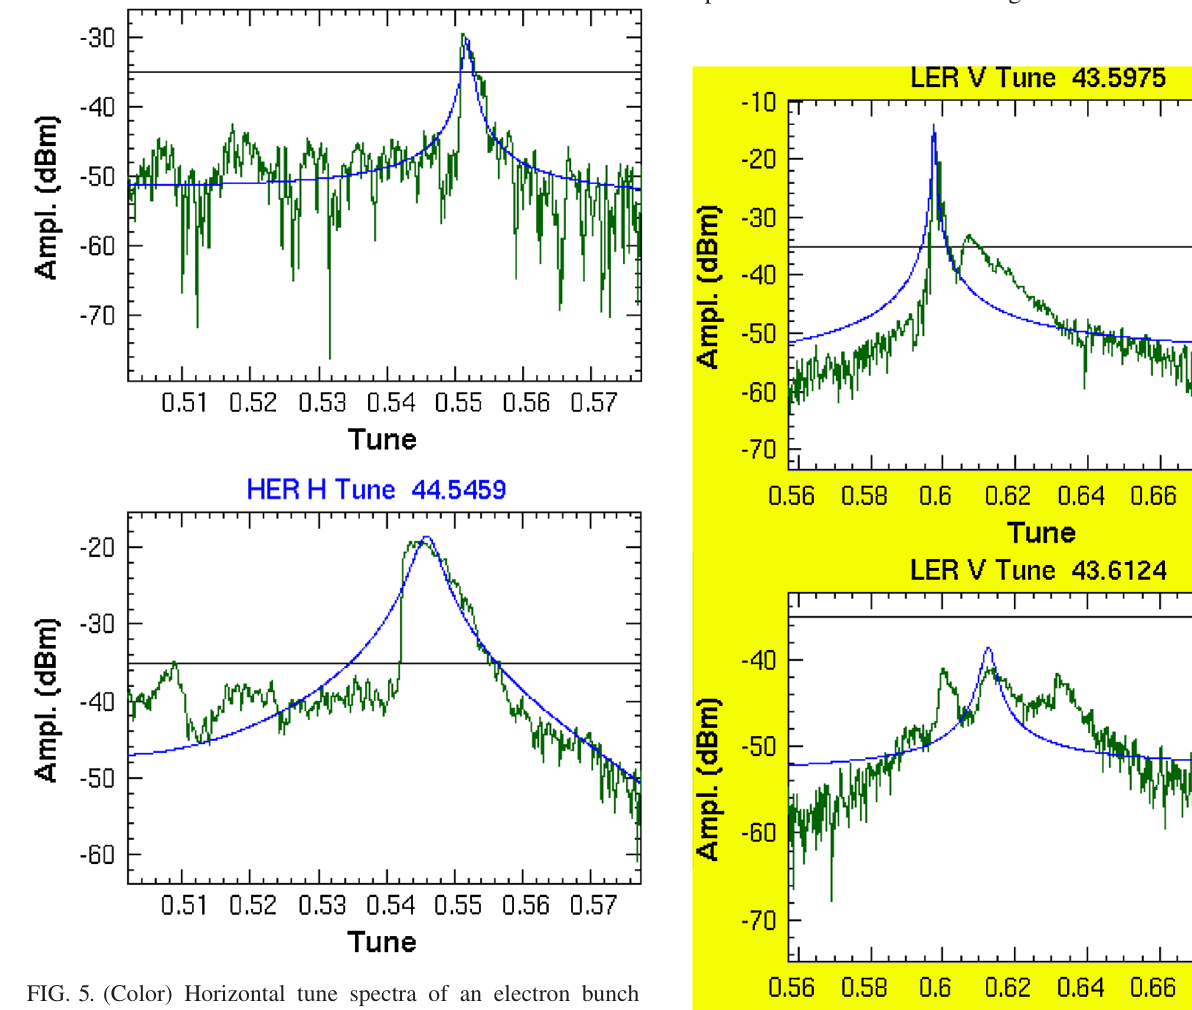
FIG. 5. (Color) Horizontal tune spectra of an electron bunch denoted by the green curve. The blue line is a resonant curve fitted to a single peak. The peak corresponds to the H mode. The excitation level changes from (cid:3) 39 dB (upper) to (cid:3) 30 dB (lower). The L mode appears as a second peak that is located around a tune of 0.509 in the lower panel. An amplitude of (cid:3) 20 dBm at the detector corresponds to an amplitude of 6 (cid:3) m at the IP.